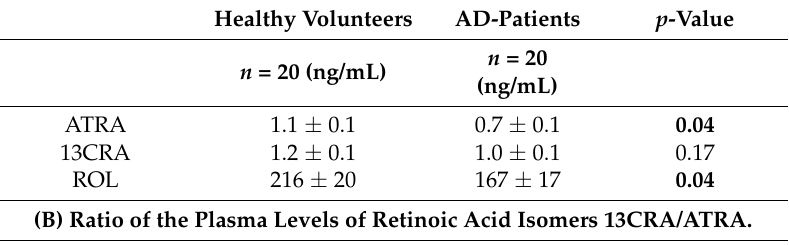
Table 3. ( A ) retinoic acid and retinol concentrations and ( B ) a calculated ratio of the plasma levels of retinoic acid isomers 13CRA/ATRA determined, based on plasma concentrations originating from healthy volunteers as well as